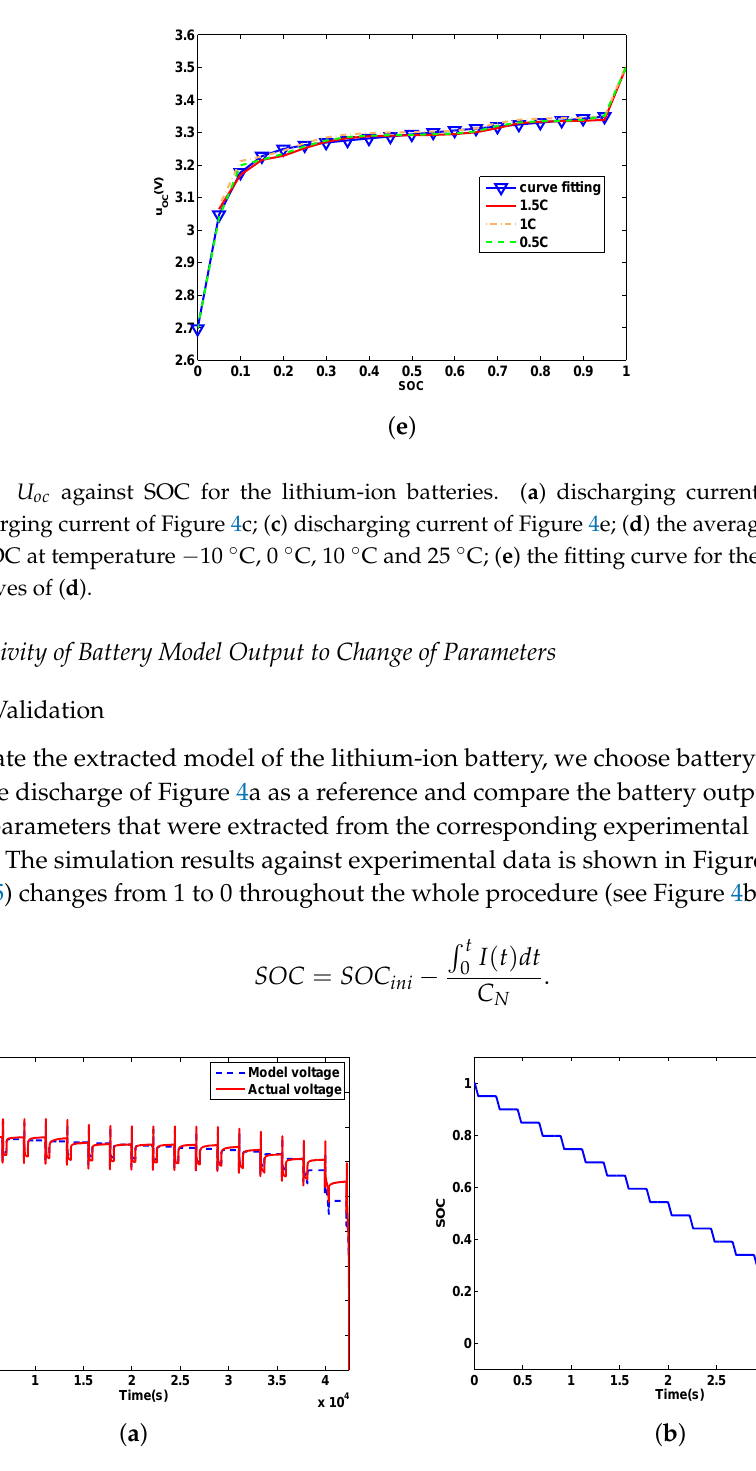
Figure 8. Comparison between voltage response of the battery and the battery model throughout the whole range of SOC with the discharge current of Figure 4a. ( a ) Measured and modeled battery voltage; ( b ) SOC with